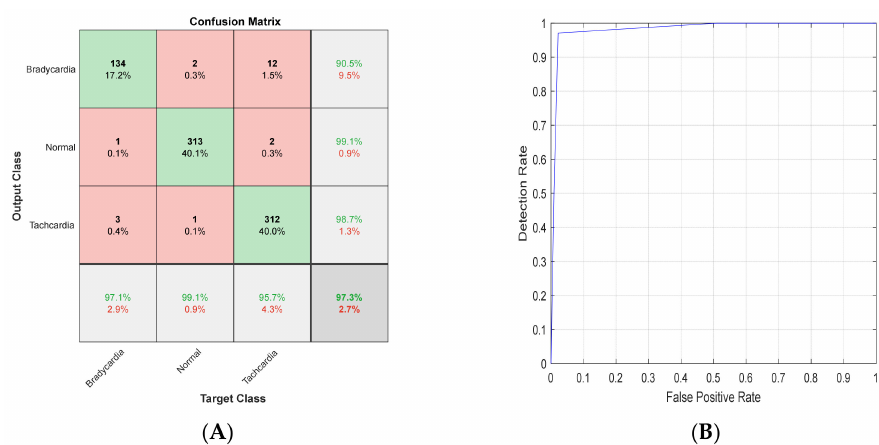
Figure 18. ( A ) Confusion matrix and ( B ) ROC for ShuffleNet with Scalogram